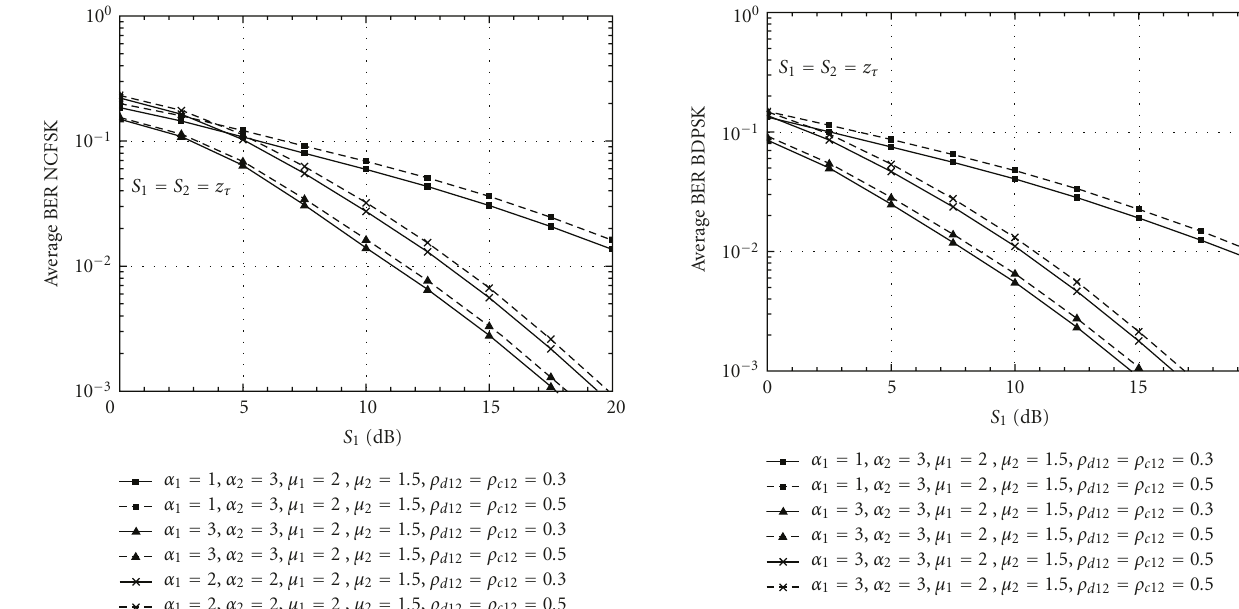
Figure 3: Average bit error probability (ABER) versus average SIR’s at the input branches of the balanced dual-branch switched-and- stay combiner, S 1 , for BDPSK modulation scheme and several values of ρ 12 d , ρ 12 c , μ 1 , μ 2 , α 1 , and α 2